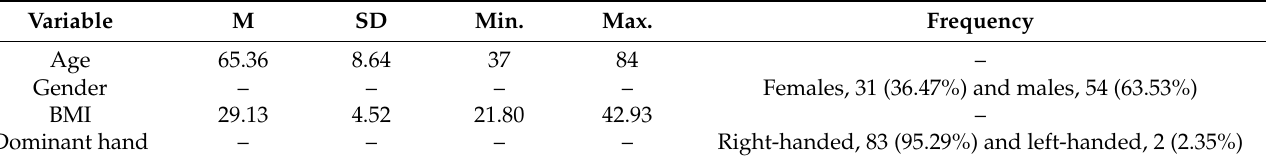
Table 1. The final sample description ( N =